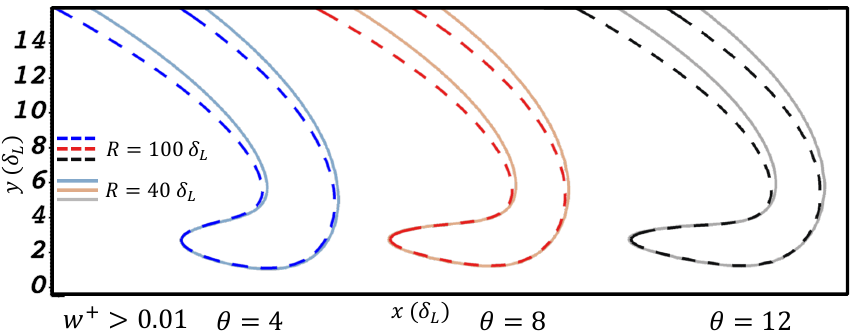
Figure 11. Flame shape under critical velocity condition for different channel half-widths R = 40,100 δ L and gas expansion coefficients θ = 4,8, 12 (isothermal walls). Lines show the zone of normalized reaction rate w + > 0.01.